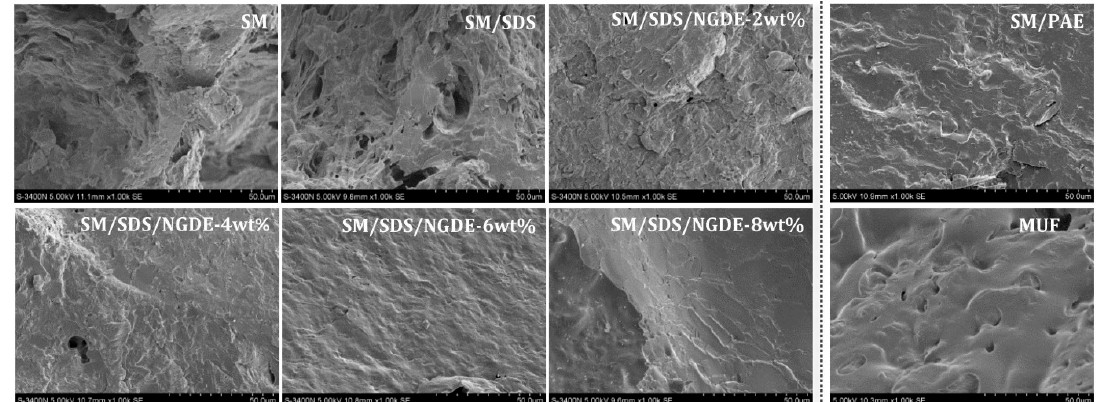
Figure 4. The fracture surface micrograph of the different cured adhesives: 0 (SM adhesive), 1 (SM/SDS adhesive), 2 (SM/SDS/NGDE-2 adhesive), 3 (SM/SDS/NGDE-4 adhesive), 4 (SM/SDS/NGDE-6 adhesive), 5 (SM/SDS/NGDE-8 adhesive), 6 (SM/PAE adhesive), and 7 (MUF resin).